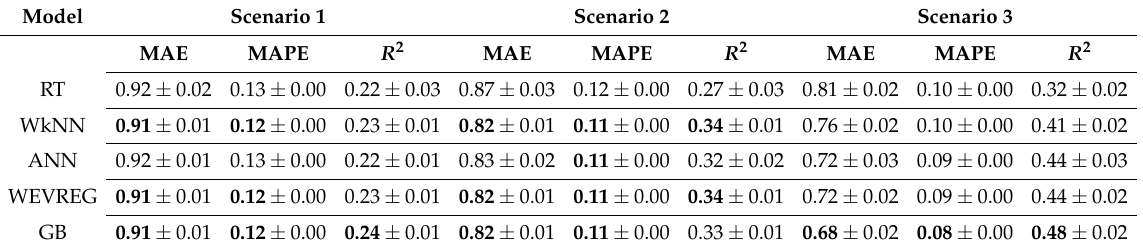
Table 9. Model performance with selected features (for MAE and MAPE lower is better, for R 2 higher is better).